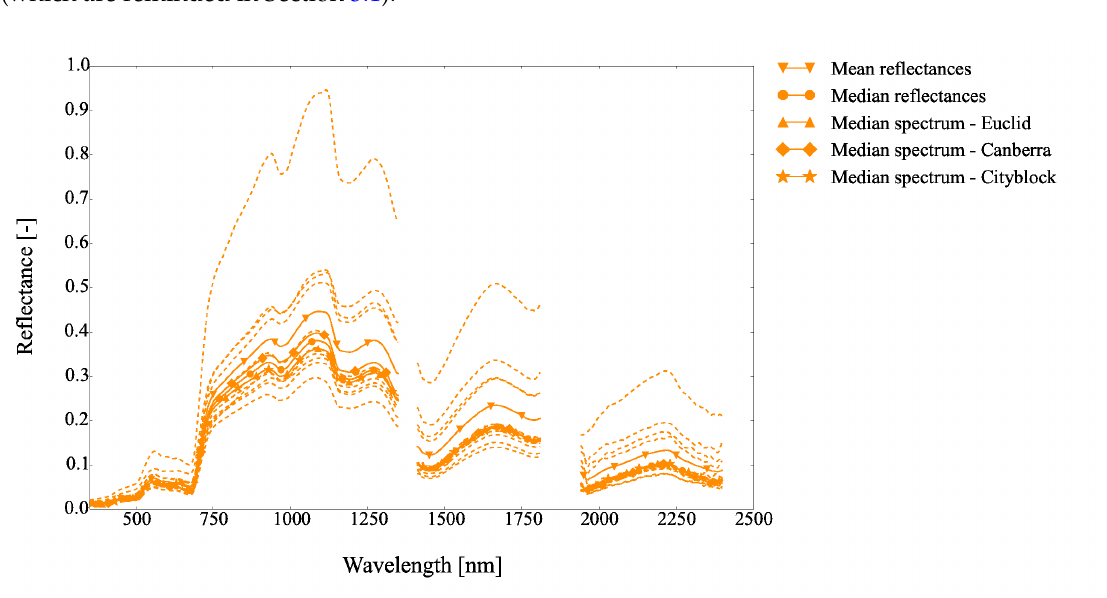
Figure 4. Median spectra, spectrum of mean reflectances, spectrum of median reflectances of Eleocharis quinqueflora